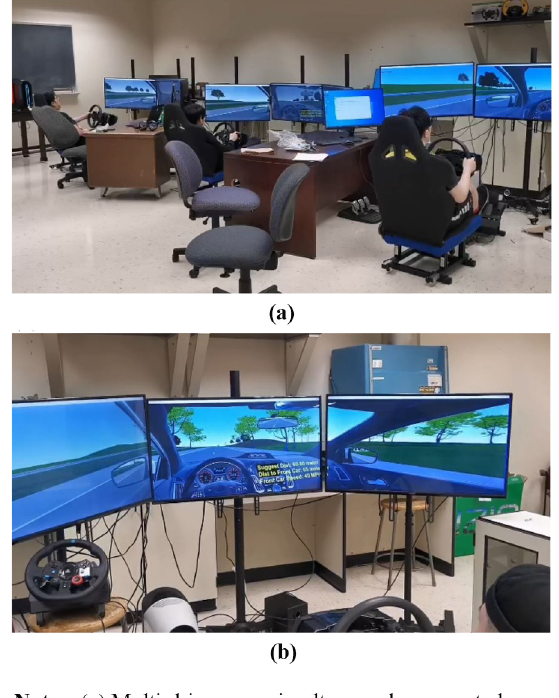
Figure 3 Multi-driver driving simulator system and